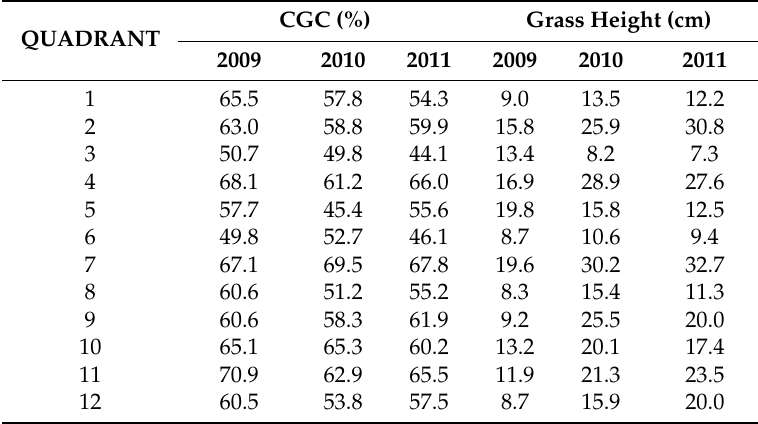
Table 1. Average (or mean) of field data for Coverage of Grass Canopy (CGC) and grass height in the quadrants measured in Cuchillas de la